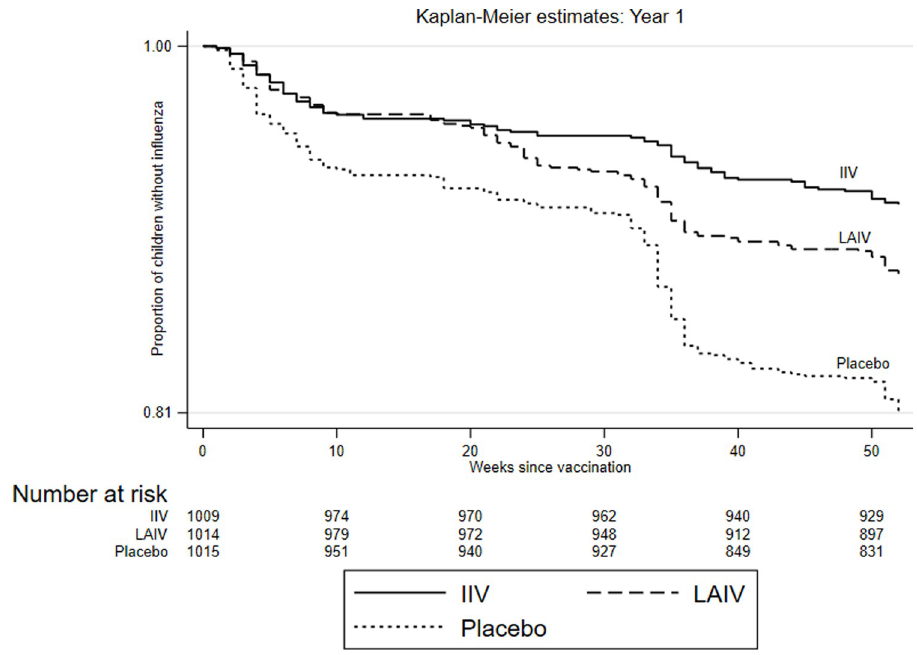
Fig 3. Kaplan–Meier curves of time to influenza infection by vaccine/placebo group for study Year 1. IIV, inactivated influenza vaccine; LAIV, live attenuated influenza vaccine.